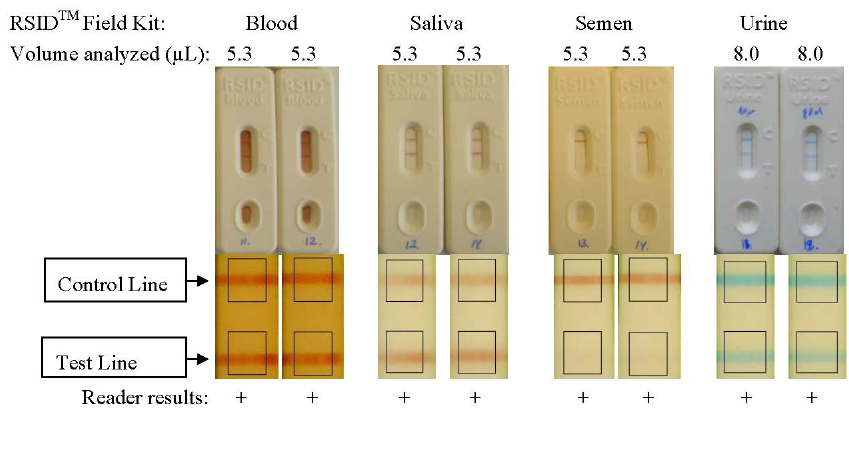
Figure 6. Results of RSID™ Reader analysis using Field Kit Protocol. Top —Digital image of cassettes (C—Control; T—Test) with analyzed volumes indicated. Bottom —Images taken from RSID™ Reader. Results as scored by RSID™ Reader are shown (positive [+] or negative [ − ]). The RSID™-Semen test with 5.3 µL of semen demonstrates a high dose hook effect, however a positive result was still scored by the RSID™ Reader.